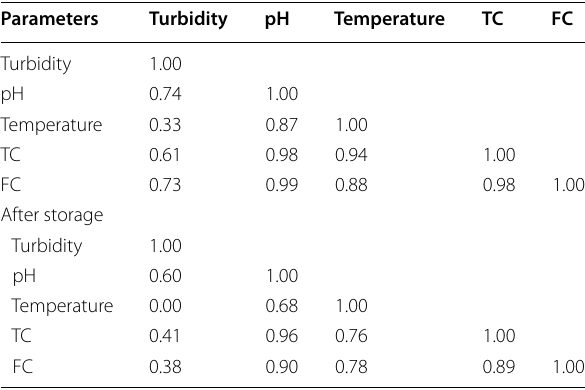
Table 3 Correlation coefficients among water quality parameters before and after storage